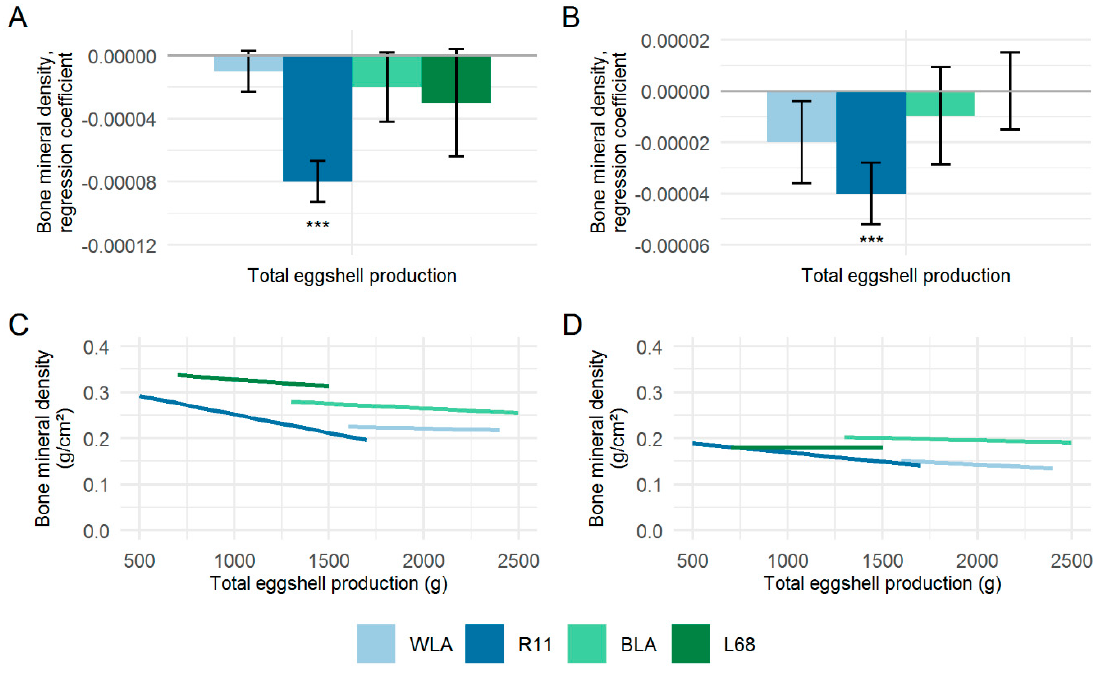
Figure 4. Regression coefficients ( β ) ± standard errors of regression of total eggshell production pertaining to the bone mineral densities of the tibiotarsus ( A ) and humerus ( B ), and the effect of total eggshell production on the bone mineral densities of the tibiotarsus ( C ) and humerus ( D ) in four different chicken layer lines (WLA, R11, BLA, L68). Significant regression coefficients are marked with asterisks (*** p < 0.001).